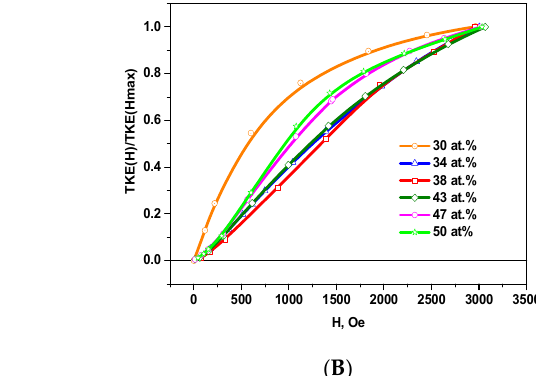
Figure 5. Hysteresis loops for nanocomposites (CoFeZr) x (MgF 2 ) 100 − x on the glass substrates at different concentrations x, in the inset the dependences of the coercive force Hc on the metal concentration x in nanocomposites is presented.